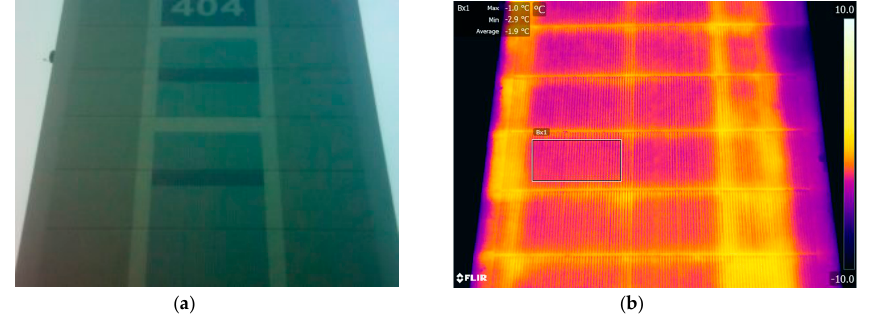
Figure 2. Images of the test wall for Case 1 ( a ) Visible; ( b ) infrared.